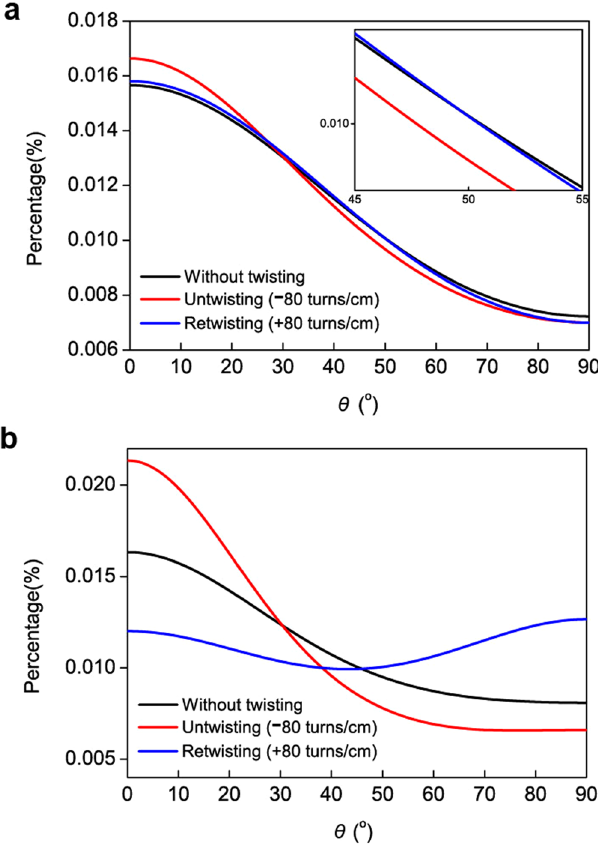
Figure 4. Orientation angles of individual CNTs in the one-tethered CNT yarn. ( a ) CNT orientations obtained around the fixed end of the CNT yarn without twisting or untwisting, with untwisting ( − 80 turns cm − 1 ) and with twisting ( + 80 turns cm − 1 ). ( b ) CNT orientations obtained near the free end without twisting or untwisting, with untwisting ( − 80 turns cm − 1 ) and with twisting ( + 80 turns cm − 1